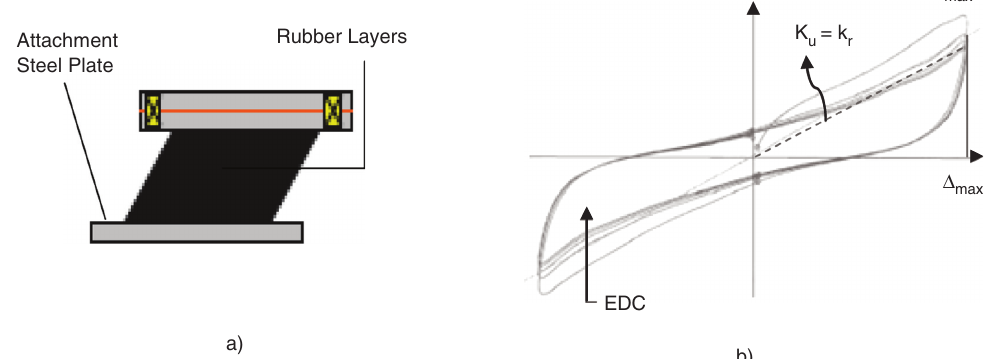
Fig. 4. HDRB: (a) Deformation pattern; (b) Equivalent linear hysteretic